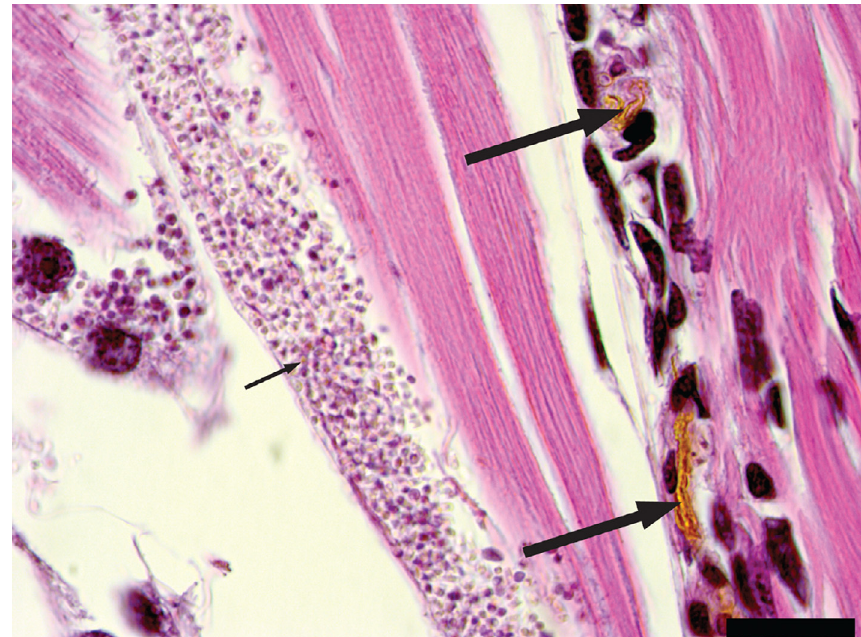
Figure 2. Histological sections (hematoxylin and eosin) of Dictyocoela diporeiae n. sp. developmental stages in an infected Diporeia sp. collected from Lake Superior. Notice the individual spores (small arrow) replacing skeletal muscle and melanized hemocytic infiltration in adjacent muscle tissue (large arrows). Scale bar = 25 l m.